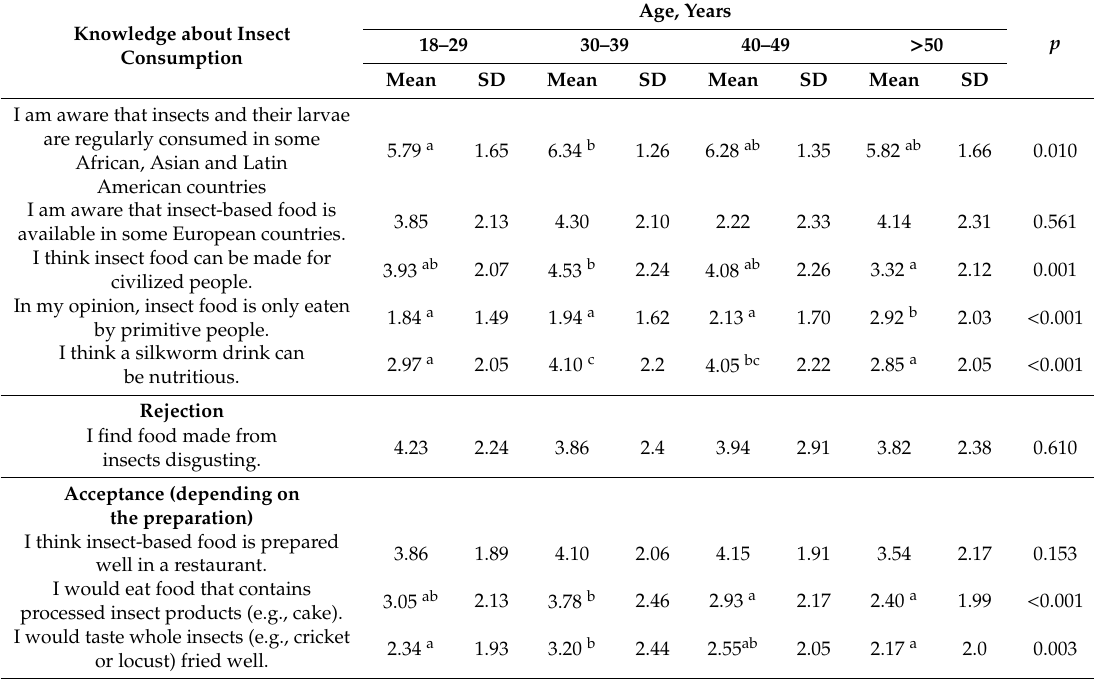
Table 3. E ff ect of age of respondents on opinions on insect-based food and their